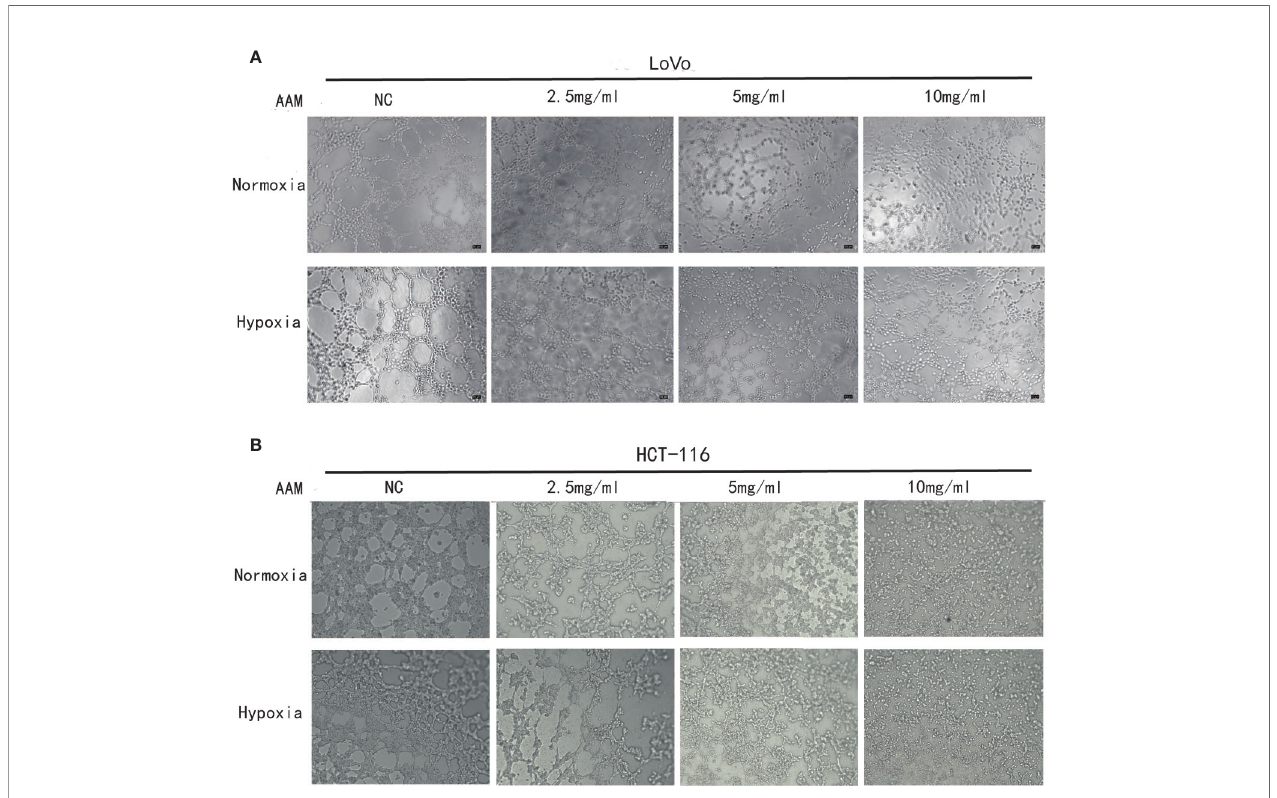
FIGURE 9 | AAM inhibits VM formation of HCT-116 and LoVo cells. VM formation assay. HCT-116 (A) or LoVo (B) cells were seed into 96-well plate which had been precoated with matrigel and incubated with AAM (2.5, 5, and 10 mg/ml) under normoxia and hypoxia. The representative images were shown in magni fi cation of 50× (HCT-116) and 50×